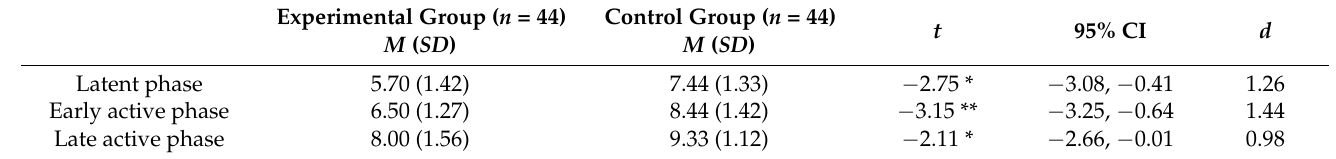
Table 2. Comparisons between experimental and control groups on pain intensity during the stages of